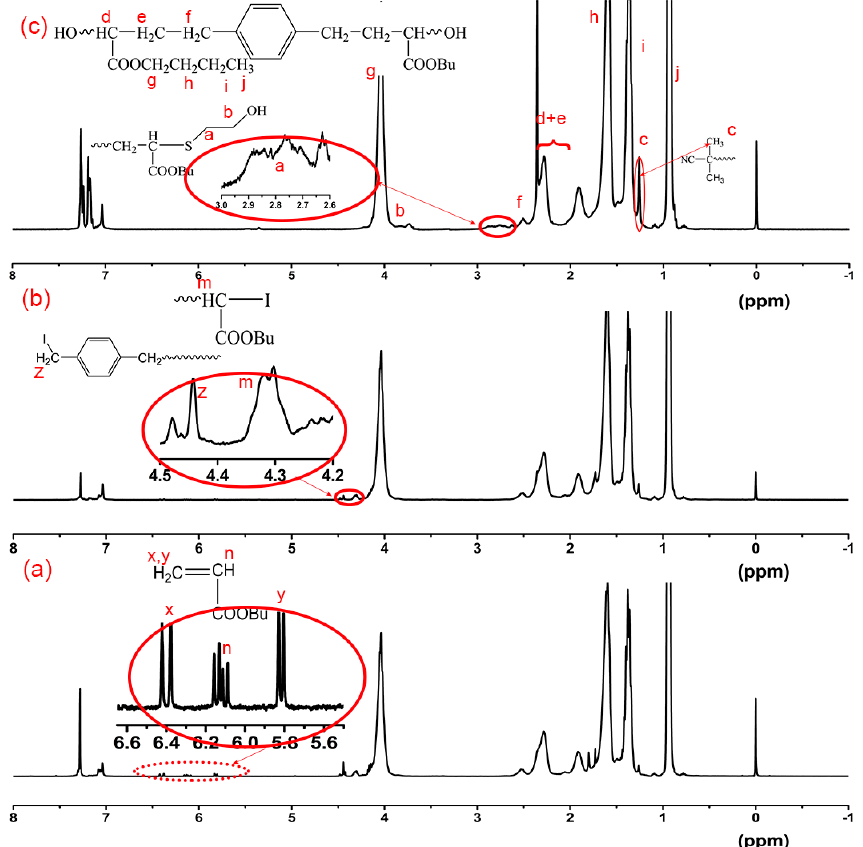
Figure 1. 1 H NMR spectra of the polymers respectively obtained from ( a ) the DITP of n -BA using AIBN as initiator and DIX as transfer agent for 1 h, and ( b ) for complete consumption of BA. ( c ) The polymer obtained after converting the iodide group at the ends of the polymer in (b) into the hydroxyl group through reaction with β